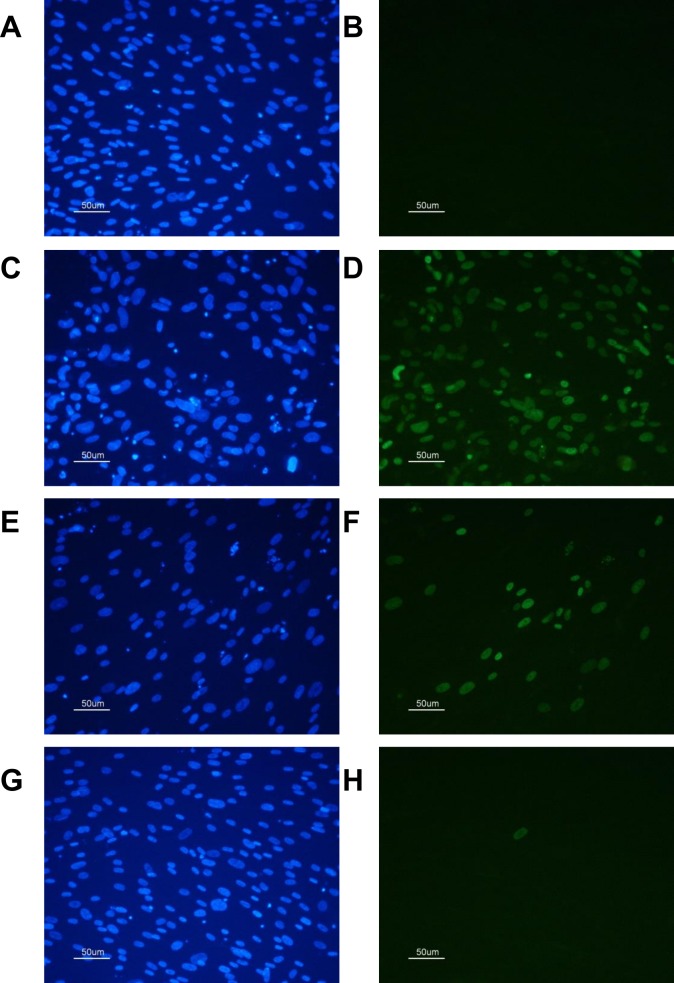
CMV infected HFF cells stained using DAPI and MABX.A Uninfected HFF cells (DAPI), B: Uninfected cells (MABX) C, D: Cells infected with AD169, no UV-C treatment, C: DAPI, D: MABX. E, F: Cells infected with AD169, 10 seconds UV-C treatment (5 cm), E. DAPI, F: MABX, G, H: Cells infected with AD169, 50 seconds UV-C treatment (5 cm) G: DAPI, H: MABX.